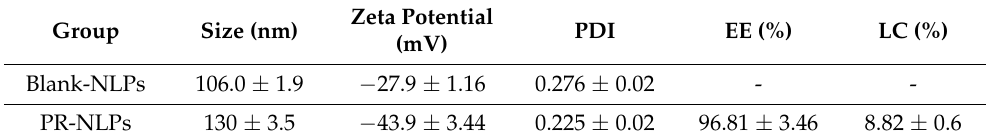
Table 3. Diameter, zeta potential, PDI, and EE of Blank-NLPs and PR-NLPs (n = 3, mean value ± SD).